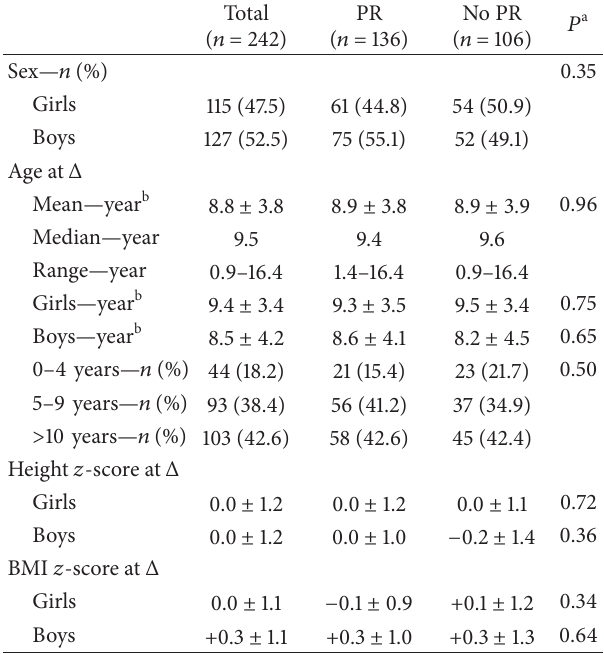
Table 1: Characteristics of the clinical series at